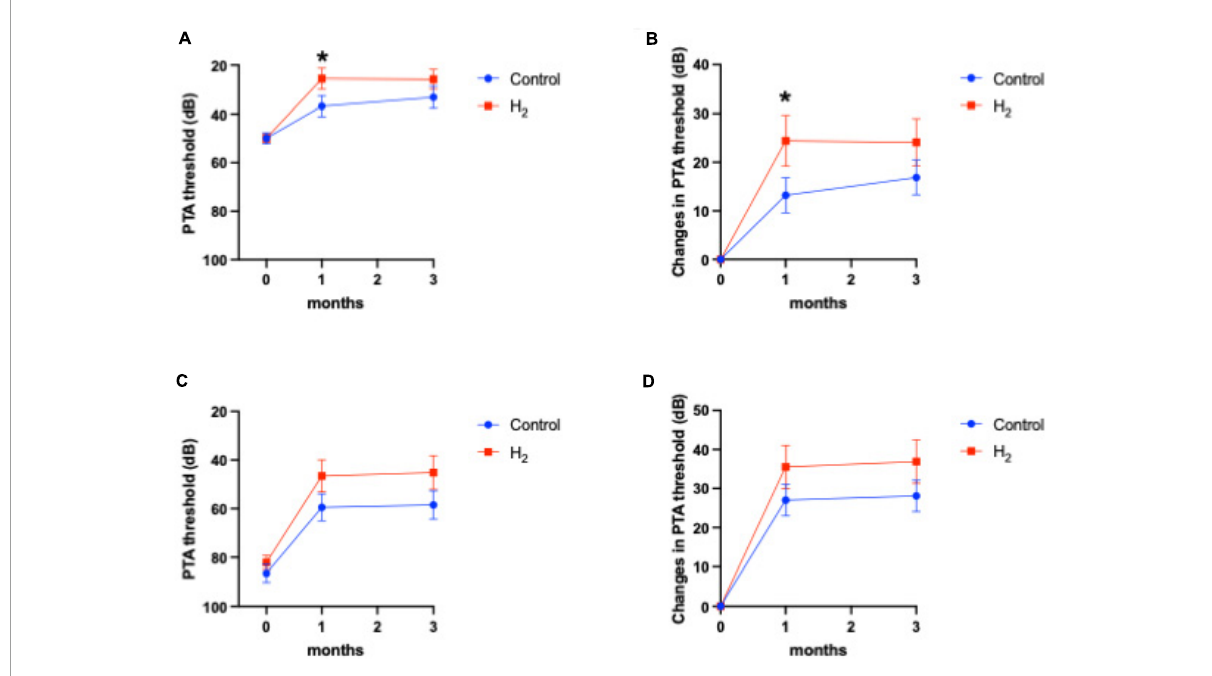
FIGURE4 Hearing outcomes depending on the severity of hearing loss at the initial visit. (A) PTA threshold among patients with mild hearing loss. (B) Changes in the PTA threshold among patients with mild hearing loss. (C) PTA threshold among patients with severe hearing loss. (D) Changes in the PTA threshold among patients with severe hearing loss. Both the PTA threshold and changes in PTA threshold were significantly better in the H 2 group 1 month after treatment among patients with mild hearing loss. However, these significant differences disappeared 3 months after treatment. There were no significant differences between the H 2 and control groups in patients with severe hearing loss. * P < 0.05.